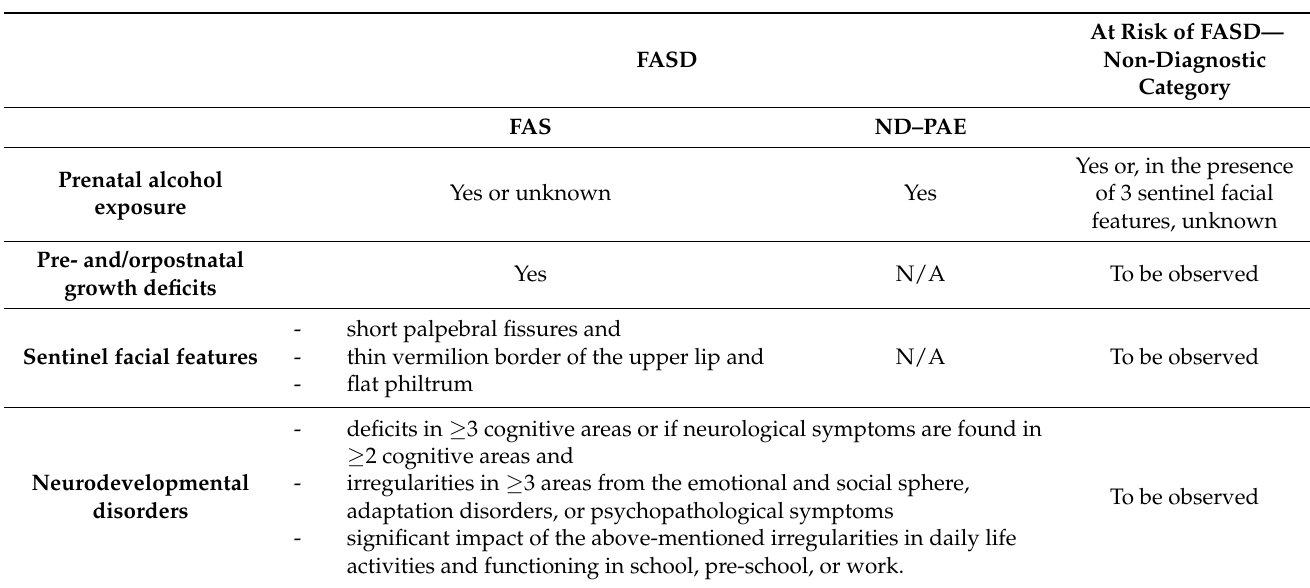
Table 2. Overview of recommended FASD diagnostic